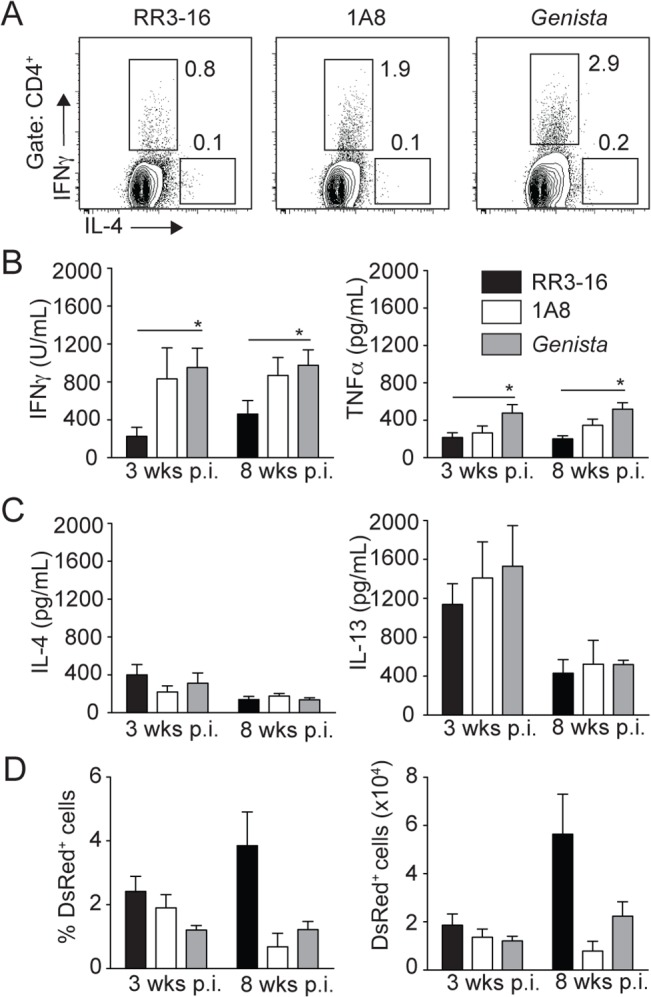
Early absence of neutrophils allows the development of L. mexicana-specific Th1 cells.(A) RR3-16-treated, 1A8 PMN-depleted C57BL/6 and Genista mice were inoculated i.d. with 106 metacyclic L. mexicana-DsRed in the ear dermis. 3 and 8 weeks following infection, dLN cells were recovered and analyzed. Representative flow cytometry profiles of intracellular IL-4 and IFNγ expression in CD4+ dLN T cells isolated 3 weeks p.i. (B) 3 and 8 weeks following parasite inoculation secretion of IFNγ, TNFα (C) IL-4 and IL-13 was quantified by ELISA in supernatants of dLN cells restimulated with UV-irradiated parasites. Data presented as the mean cytokine secretion ± SEM, n = 4/group. (D) Frequency and number of parasitized dermal CD45+DsRed+ cells was analyzed by flow cytometry. Data presented as mean ± SEM for n ≥ 4/group. Data are representative of 2 independent experiments. * p<0.05.